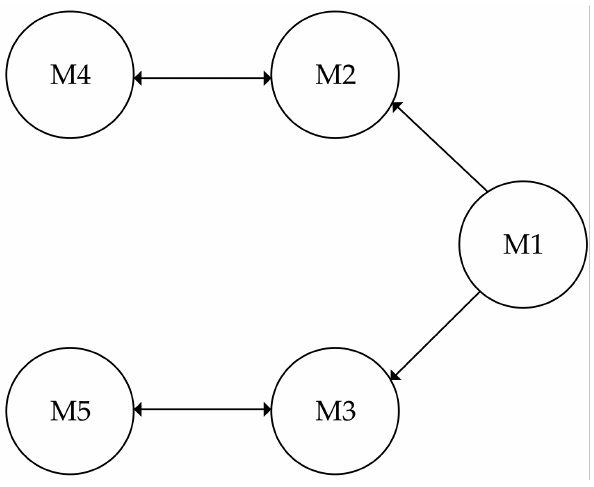
Figure 3. Communication topology of vehicles.